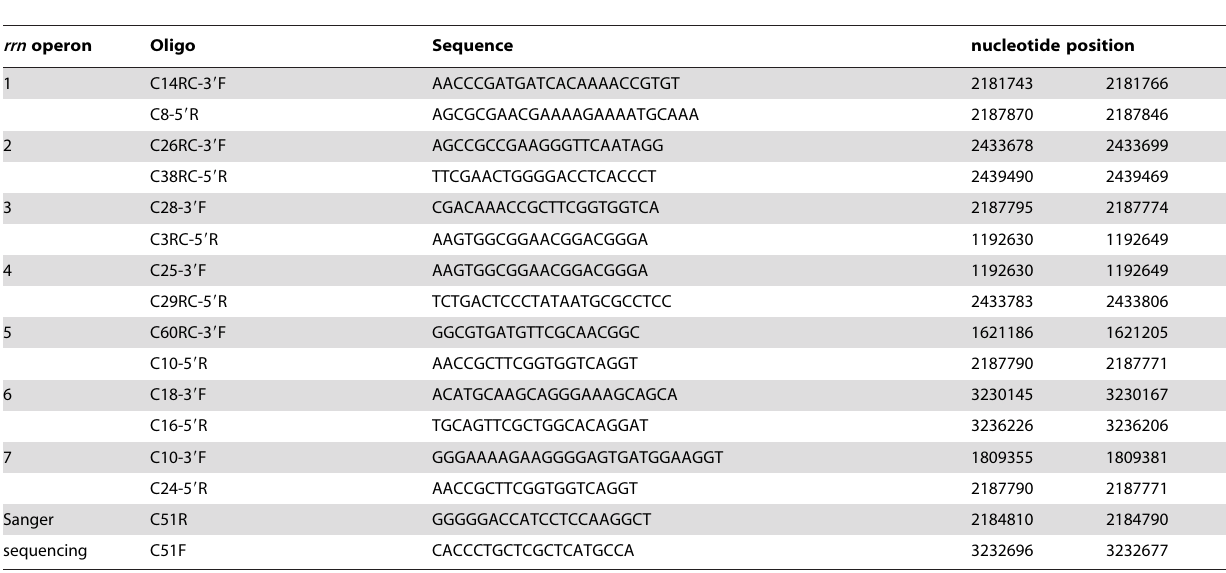
Table 1. Oligos for amplification of rrn regions 1–7 and resoving rrn operon structures by Sanger sequencing.